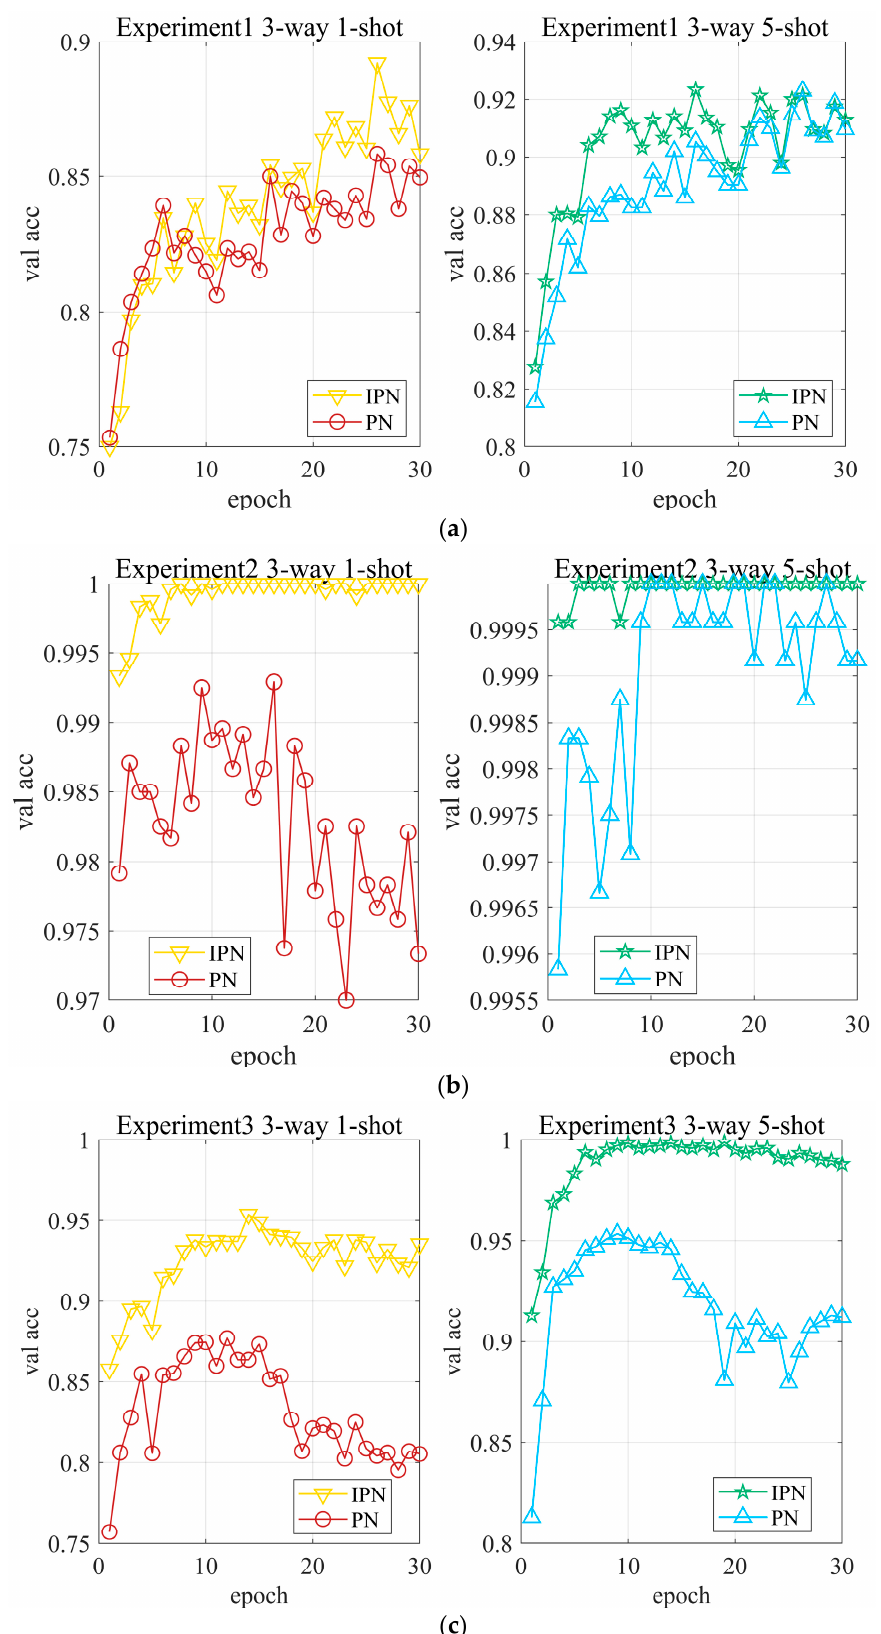
Figure 8. Validation accuracies of PN and IPN in experiments. ( a ) Experiment 1, ( b ) Experiment 2, ( c ) Experiment